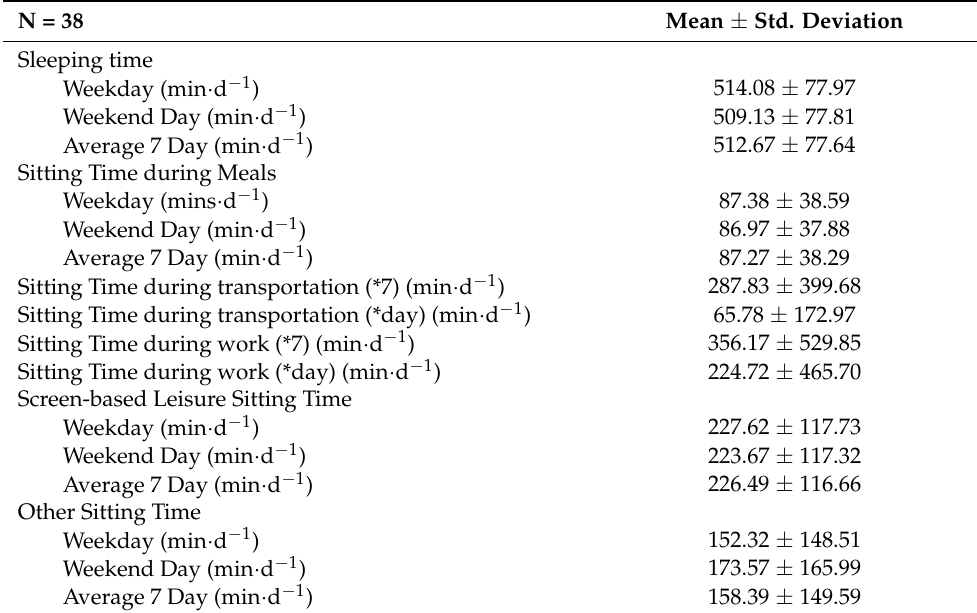
Table 5. Descriptive statistics of the average minutes spent in different sedentary domains from the SIT-Q-7d-CHI.